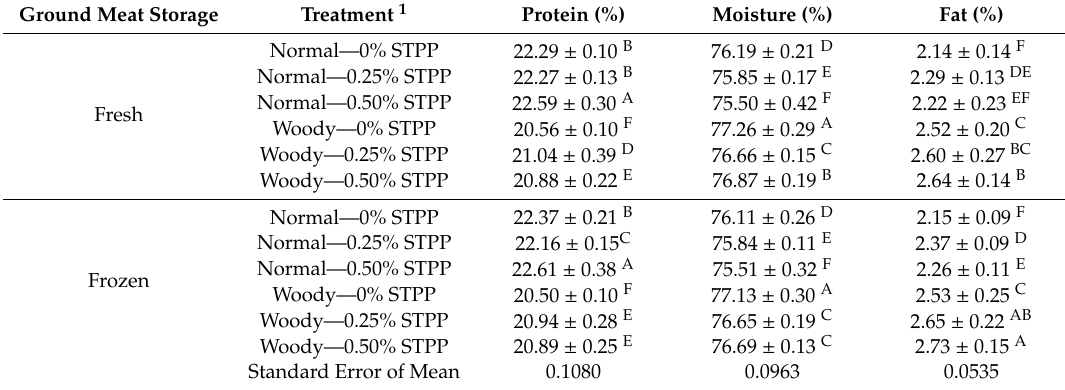
Table 2. Proximate analysis (protein, moisture, and fat) data for fresh vs. frozen ground chicken breast (normal and woody) treated with di ff erent levels of sodium tripolyphosphate (STPP; lsmean ± SD). Ground Meat